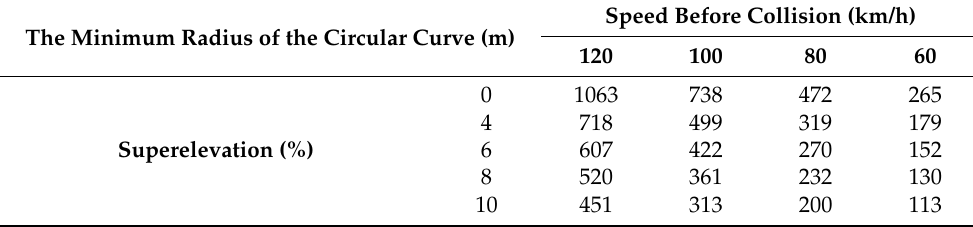
Table 2. Minimum radius of the circular curve under critical conditions of rollover after a collision. The Minimum Radius of the Circular Curve (m)